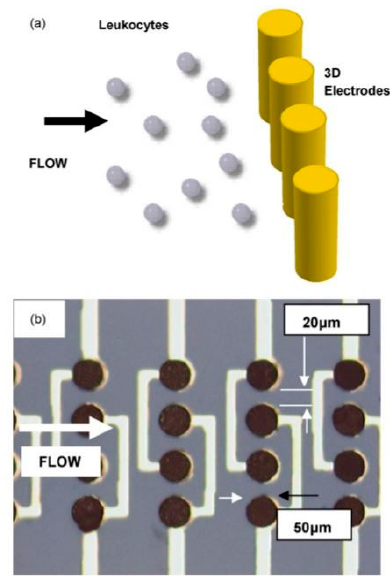
Figure 20. Three-dimensional cylindrical electrodes utilized in [75]. ( a ) Sketch of leukocytes ap- proaching a singe row of electrode. The height of each electrode is 50 m. ( b ) The diameter of each electrode is 50 µm with spacing between them 20 µm. The height of each electrode is 50 µm. Adapted with permission from [75]. Copyright 2006 Elsevier.